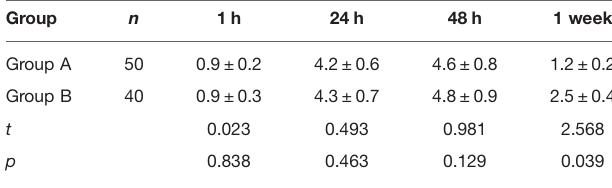
TABLE 2 | Comparison of VAS scores at different time after operation between two groups of patients (score, (cid:1) x + S ). Group